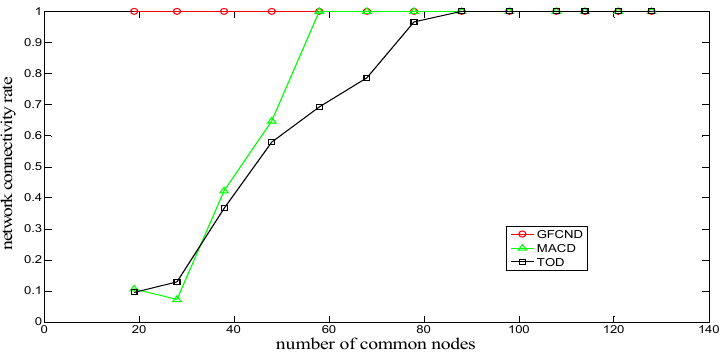
Figure 7. Network connectivity rate for deployment algorithms.